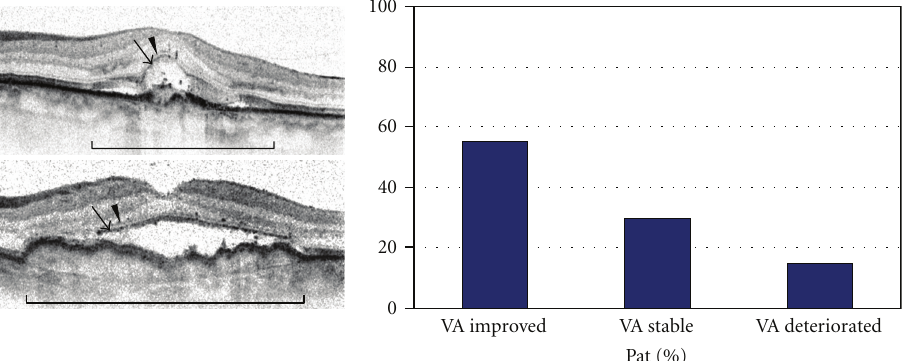
Figure 2: Group of patients with good continuity of ELM and IS/OS over the CNV lesion: exemplary baseline OCT images and final distribution of patients with improved, stable, or decreased vision after triple intravitreal ranibizumab therapy, (Brackets define the area of the CNV lesion. Arrowheads = ELM. Arrows = IS/OS border.).